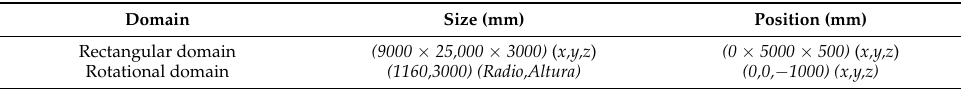
Table A1. Dimensions of the wind computational